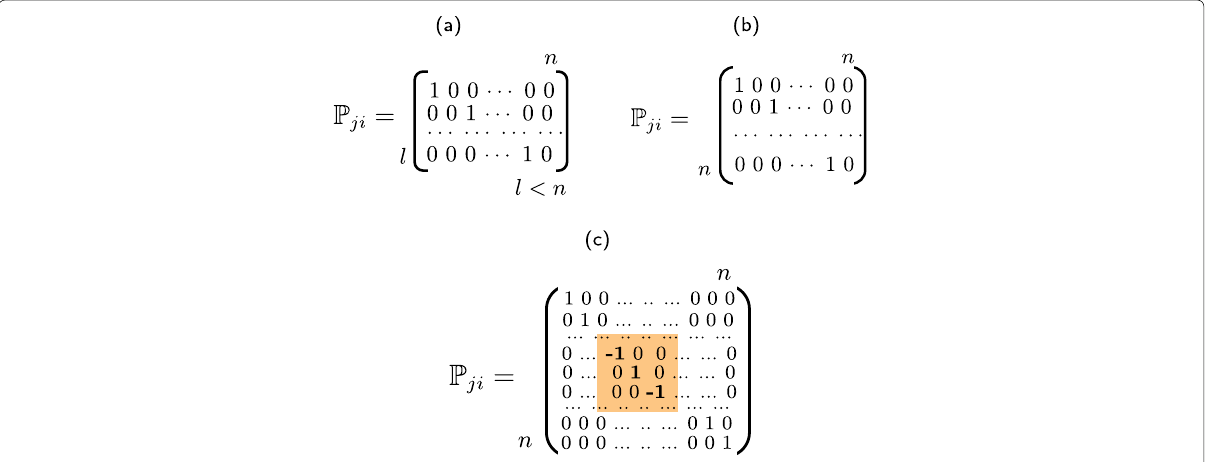
Fig. 7 Randomized transformation P ji , 1 ≤ j ≤ J , 1 ≤ i ≤ I examples: a randomized sampling, b randomized permutation, and c randomized sign flipping in the sub-block defined in orange. All transforms are